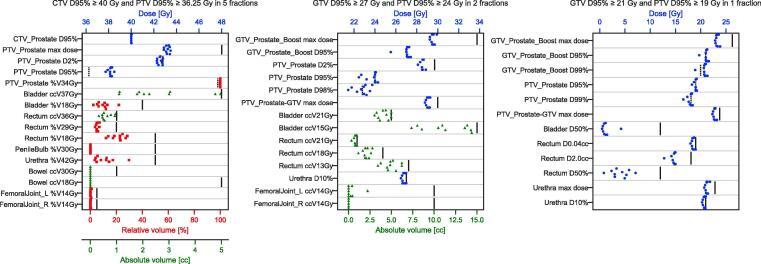
Clinical goals for each of the ten plans generated for each of the UHF schemes. Solid vertical lines indicate a clinical goal maximum threshold, with a dashed line indicating a minimum threshold.